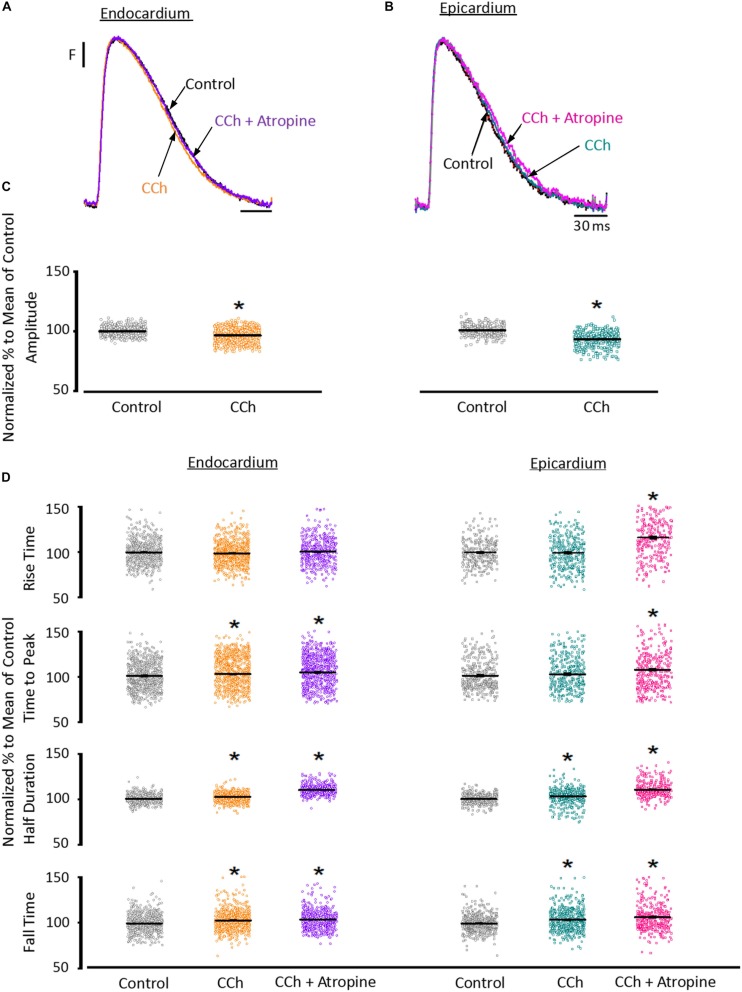
Cholinergic stimulation has a low impact on the Ca2+ transients in endocardium and epicardium. (A) Normalized fluorescent Ca2+ transients recorded, simultaneously, from endocardium and (B) epicardium using Rhod-2 and the pulsed local field fluorescence microscopy technique before and after 5 μM carbachol (CCh) and in the presence of both carbachol and 40 μM atropine. Overlapping Ca2+ transients were normalized to their maximum fluorescence. (C) Summary of the normalized amplitude of the Ca2+ transient changes, from the endocardium (circles) and epicardium (squares), before and after carbachol. (D) Data showing the kinetic changes in the normalized Ca2+ transients before and after carbachol, and after carbachol plus atropine. Means ± SEM are represented as the solid horizontal lines. *p < 0.01, N = 5 hearts.